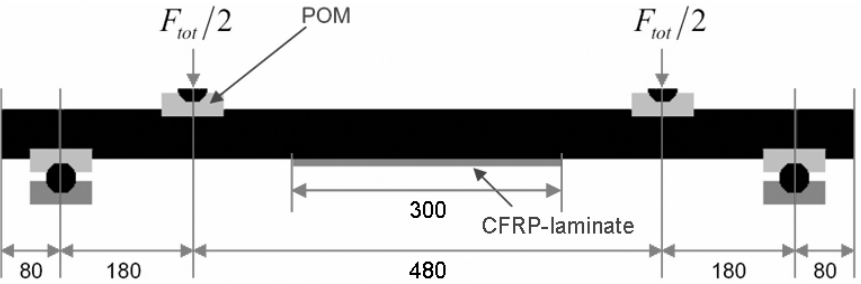
Figure 4. Four-point-bending setup with prestressed CFRP laminate on the beam’s tension